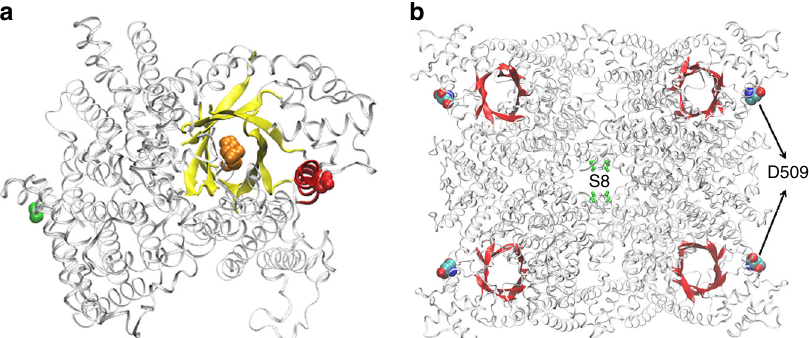
Fig. 7 Protein structure model of phosphoenolpyruvate carboxylase 2 (PEPC2) in Kalanchoë fedtschenkoi . a PEPC2 (Kaladp0048s0578.1) structural model with a glucose-6-phosphate (G6P) substrate (orange spheres) bound at the β -barrel active site (yellow). D509 (red spheres) is located at an α -helix (red) in adjacent to the β -barrel and far from the hallmark serine residue (S8, green spheres) that is the phosphorylation target of PPCK1. b PEPC tetramer structure. The phosphorylation site (S8, green) is located at the interphase of the tetramer and D509 (spheres) is located at the peripheral of the tetramer. The β -barrel active site is shown in red, and no G6P activator may be required for activation of the PEPC activity following the competitive activating model